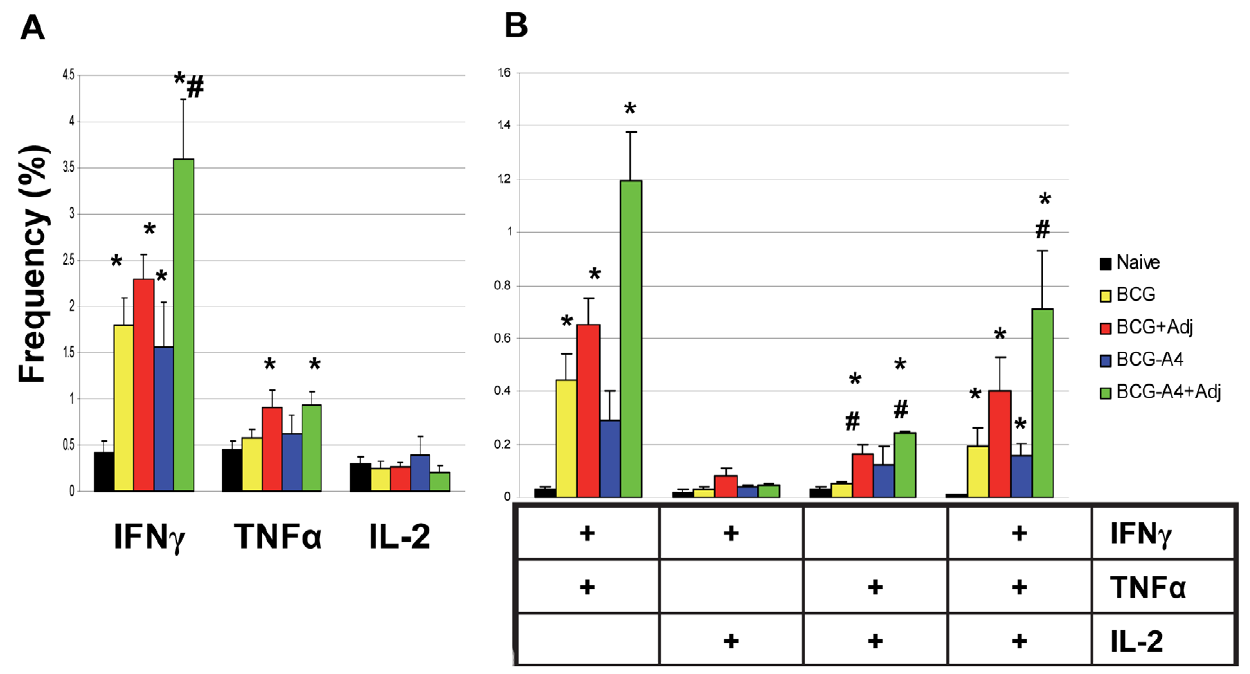
Figure 2. Muliparameter flow cytometry was used to determine the frequency (%) of (A) monofunctional CD4 T cells producing only IFN c , TNF a , or IL-2 or (B) CD4 MFT cells producing both IFN c and TNF a , IFN c and IL-2, TNF a and IL-2 or all three cytokines from naı¨ve or vaccinated mice. Splenocytes from three to five unchallenged mice per group were analyzed separately for these experiments. * Significant differences relative to naı¨ve controls ( p , 0.05). # Significant differences compared to BCG-vaccinated mice ( p , 0.05).